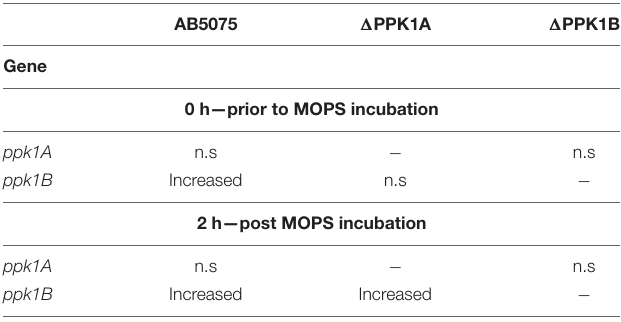
TABLE 1 | Summary of ppk1 transcriptional trends in the AV-T phase-variant vs. the VIR-O phase-variant of the corresponding